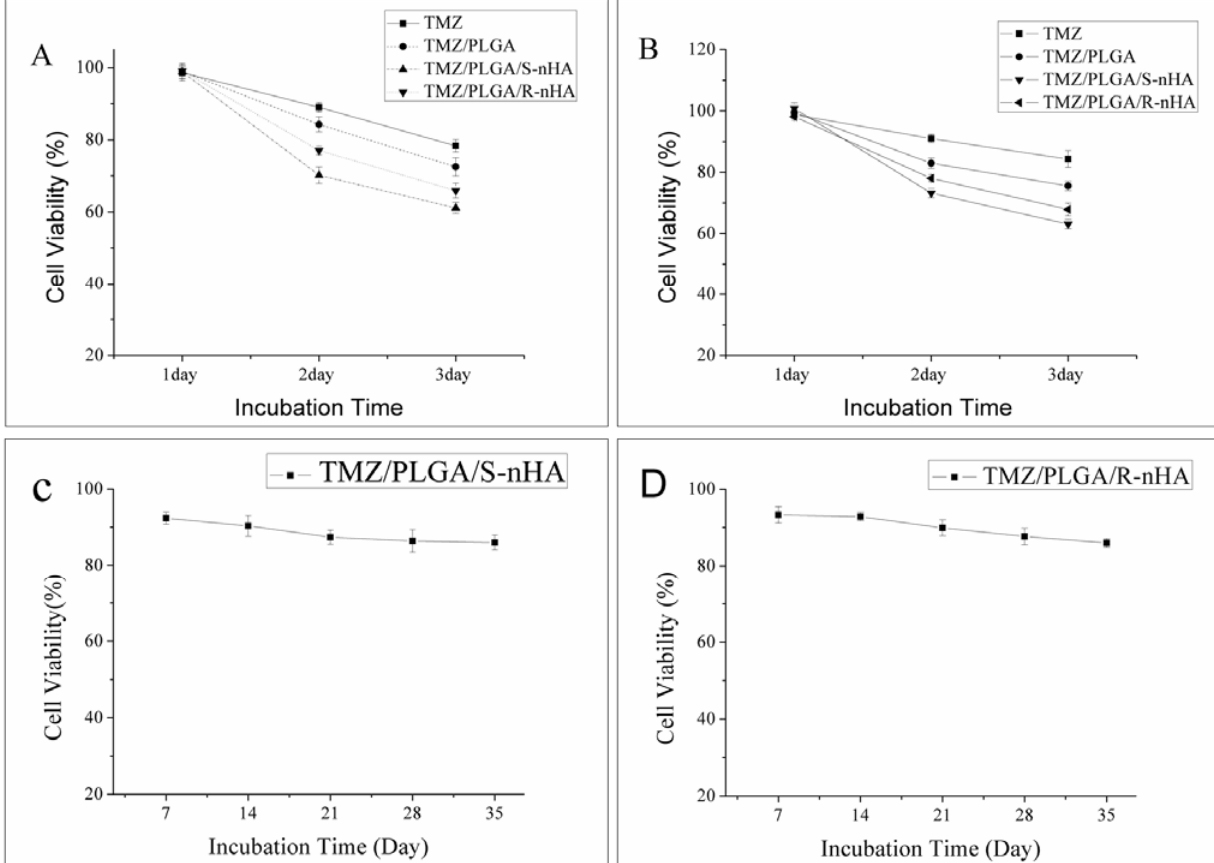
Figure 6. The effect of TMZ/PLGA/nHA microspheres on U87 glioma cells. The images show the cell viability of U87 glioma cells treated with TMZ, TMZ/PLGA and TMZ/ PLGA/nHA, and the groups not treated with drugs served as control groups. ( A ) MTT assay for detecting the proliferation of cells; ( B ) CCK-8 assay for detecting the proliferation of cells; ( C ) The effect of release liquids (7d, 14d, 21d, 28d and 35d) from the TMZ/PLGA/ S-nHA microspheres on U87 glioma cells by CCK-8 assay; ( D ) The effect of release liquids (7d, 14d, 21d, 28d and 35d) from the TMZ/PLGA/R-nHA microspheres on U87 glioma cells by CCK-8